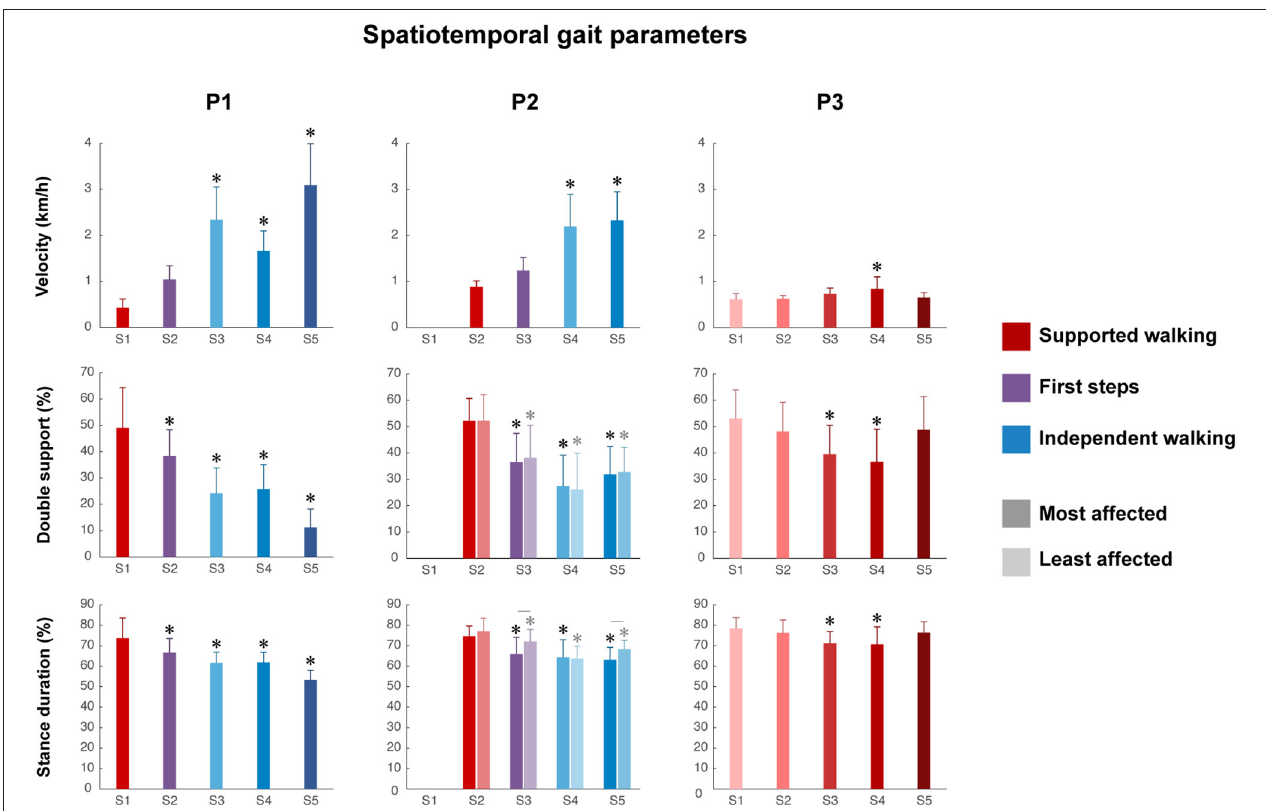
FIGURE 2 | Spatiotemporal gait parameters. Velocity, percentage of double support and stance duration from S1 to S5. Error bars indicate SDs. For the percentage of double support and stance duration of P2, the most affected side (dark color) and least affected side (light color) are shown, whereas for P1 and P3, one side is shown. Significant linear differences across sessions are denoted by asterisks, and significant interactions between session and side are denoted by lines between the most and least affected sides for P2 ( p <